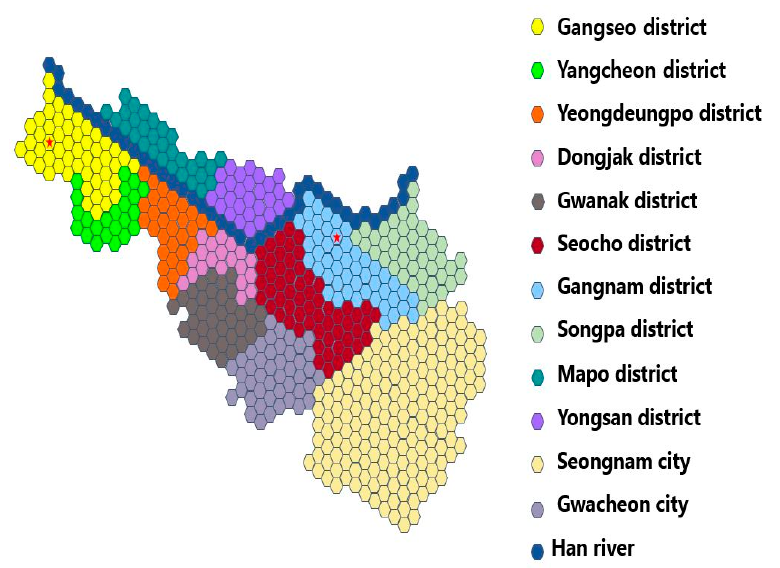
Figure 12. Two methods of route generation from Gimpo airport to COEX.